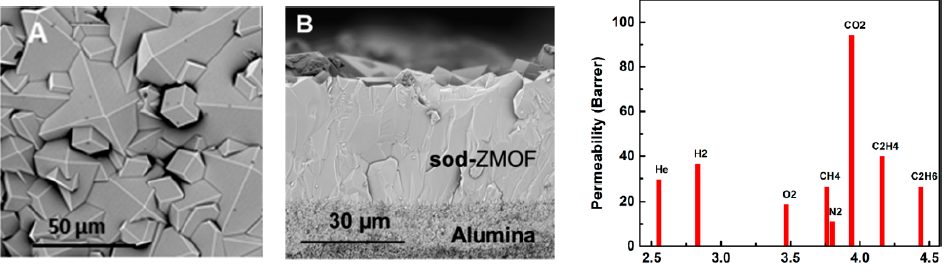
Figure 59. ( Left ) SEM images of sod-ZMOF-1 membrane supported on alumina substrate, top view ( A ), and cross-section ( B ). ( Right ) Single gas permeability vs. Lennard-Jones diameter of relevant gases (at 308 K) on sod-ZMOF-1 membranes (adapted with permission from ref. [153]).